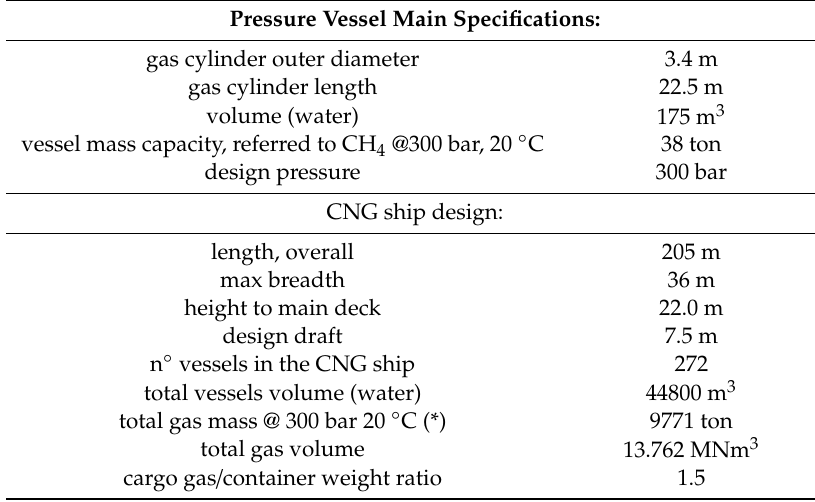
Table 2. GASVESSEL project [4]: CNG vessel and ship design main